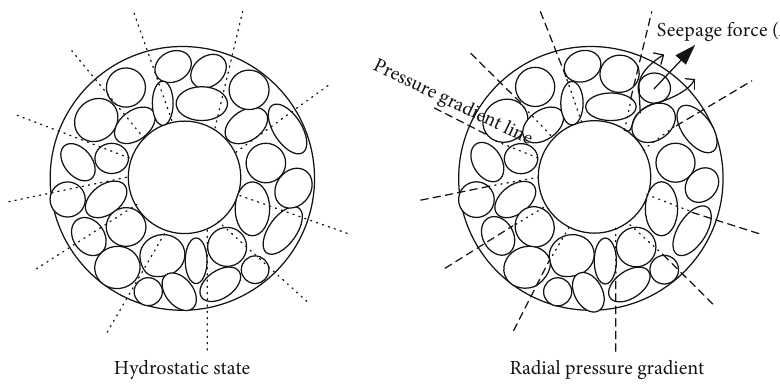
Figure 2: Schematic graph of a seepage force around a